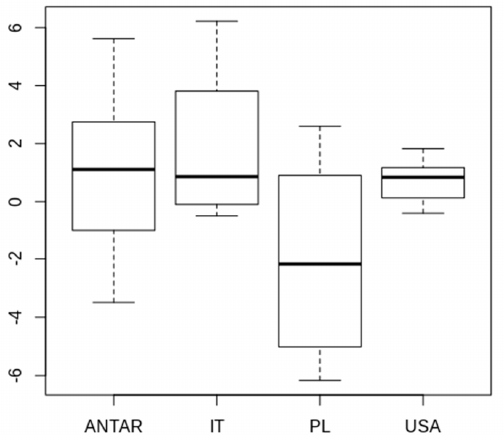
Figure 5. Differences between the studied populations of Paramacrobiotus fairbanksi Schill, Förster, Dandekar and Wolf [25] expressed by the first component of PCA performed on the measurements of chosen morphological structures (Antar, Antarctic; IT, Italy; PL, Poland; USA, USA). Minimum, maximum, median, first quartile, and third quartile for each population are presented.